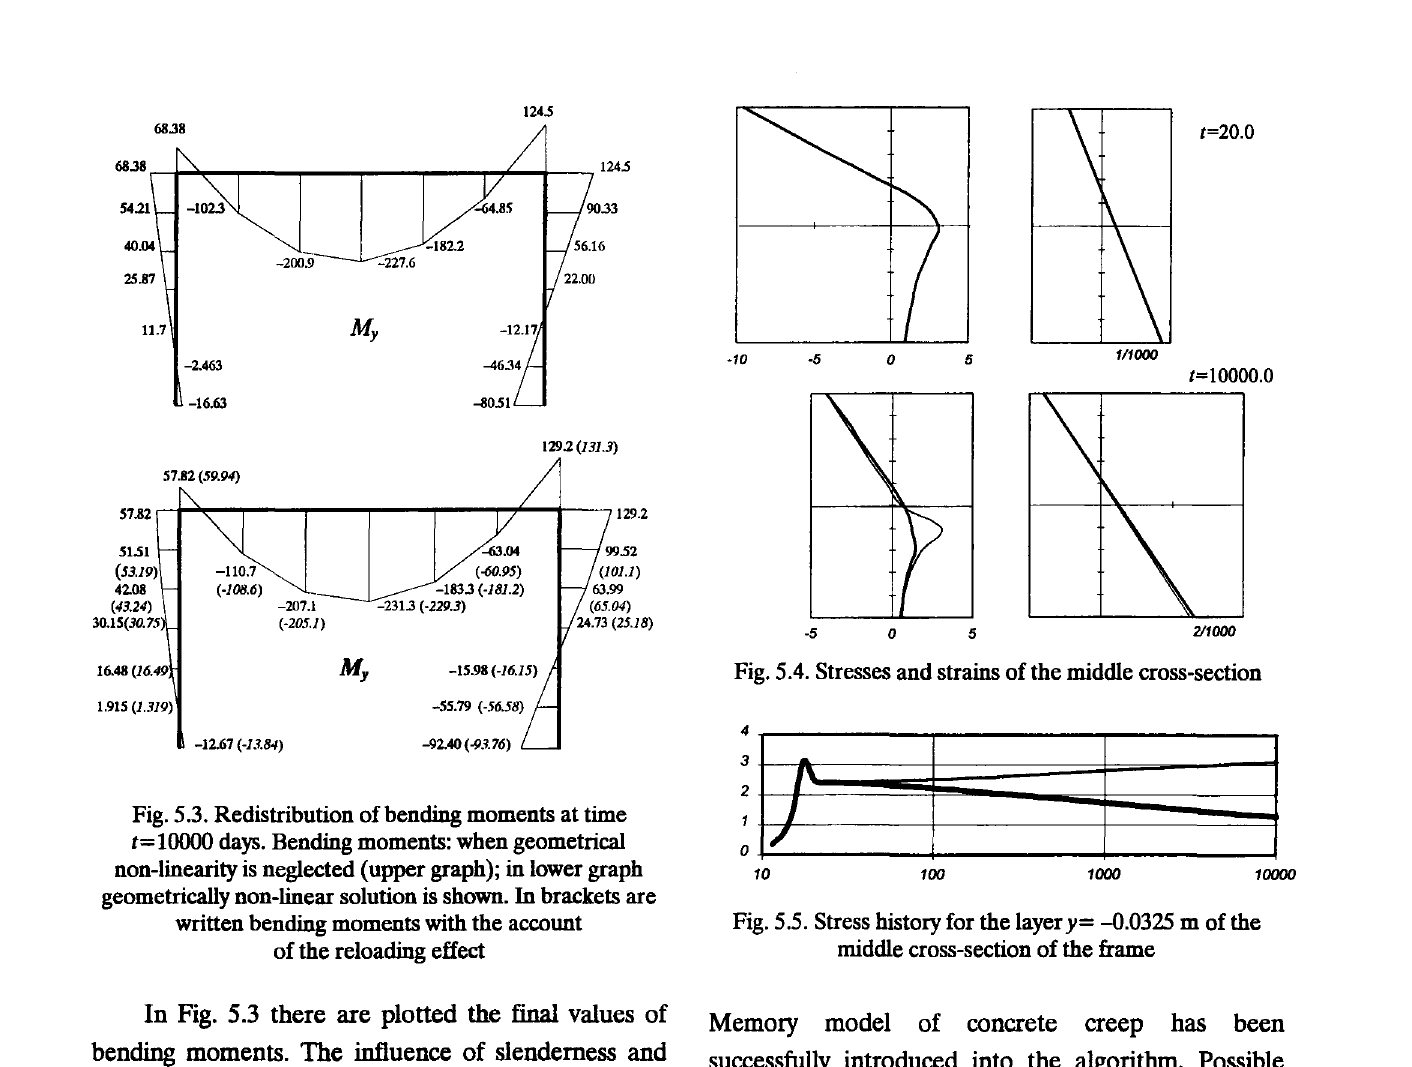
Fig. 5.4. Stresses and strains ofthe middle cross-section